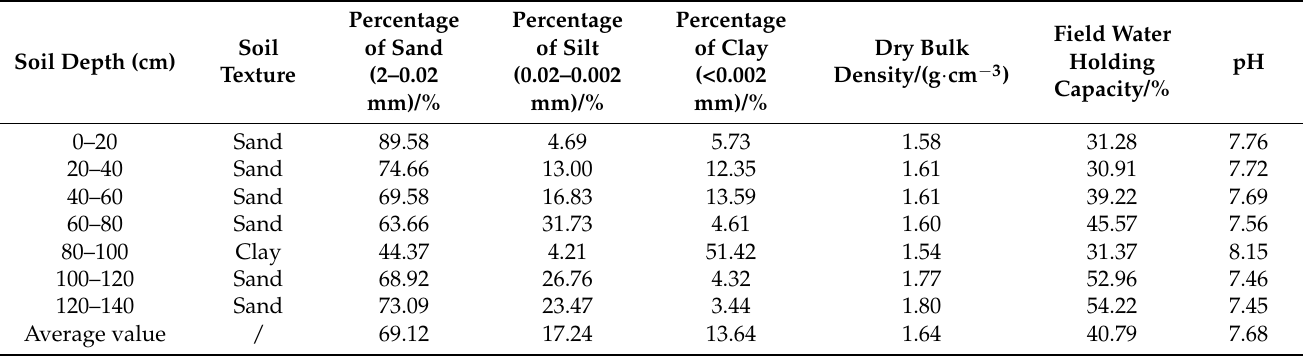
replicates for each treatment and a protection row between each treatment. There were 33 experimental plots in total, each with a length of 38 m, a width of 4 m, and an area of 152 m 2 (with an area >130 m 2 meeting the requirements of the